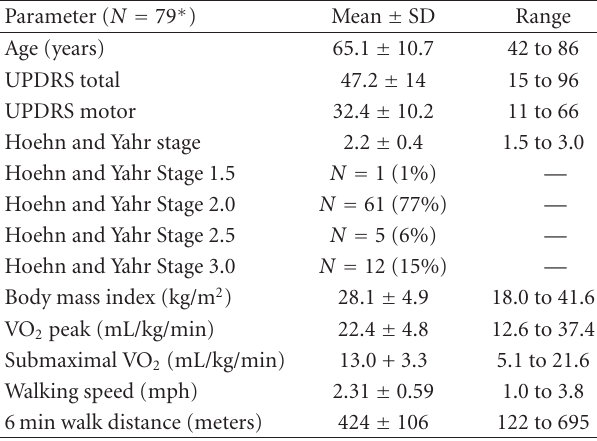
Table 1: Subject characteristics, disease severity, and physical performance measures.